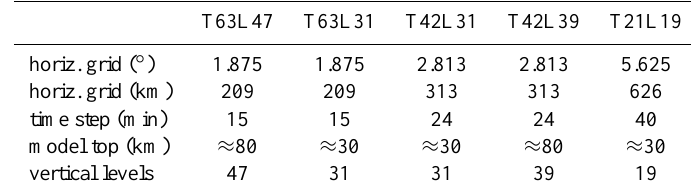
In order to study the transport path of beryllium atoms from their source in the stratosphere until their deposition the production rates were divided into 30-degree latitude bands in the stratosphere and the troposphere, following Heikkil¨a et al. (2009). The sum of all these atmospheric compartments gave the total production. The model defined tropopause was used as the vertical limiter between the stratosphere and the troposphere. Hence we ended up with 6 compartments in both the troposphere and the stratosphere (60–90 ◦ S, 30– 60 ◦ S, 0-30 ◦ S, 0–30 ◦ N, 30–60 ◦ N and 60–90 ◦ N). 10 Be pro- duced in each of these compartments was defined as a sepa- rate tracer, allowing for a quantification of where 10 Be, pro- duced in a given atmospheric region, was deposited. Air con- centrations also show the transport from source at each model level, not only at sink such as deposition flux. Please note that all particles were simulated as individual atoms in the model and the fluxes shown throughout the manuscript show the number of atoms per meter squared and time unit, and are directly comparable with atoms measured in natural archives. In order to validate the transport of atmospheric particles by the model the additional tracer 210 Pb was